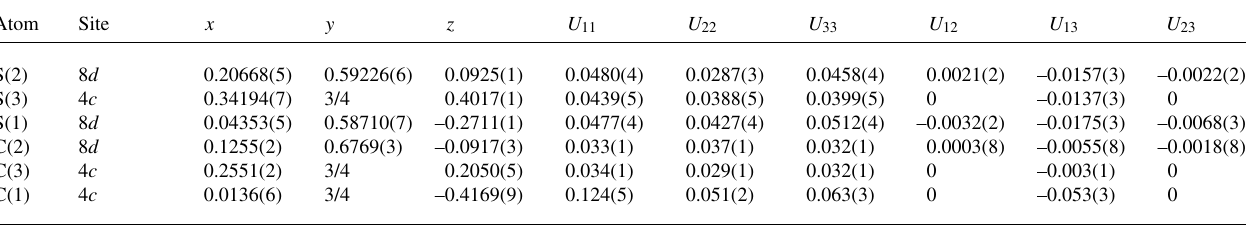
Table 3. Atomic coordinates and displacement parameters (in Å 2 ) .